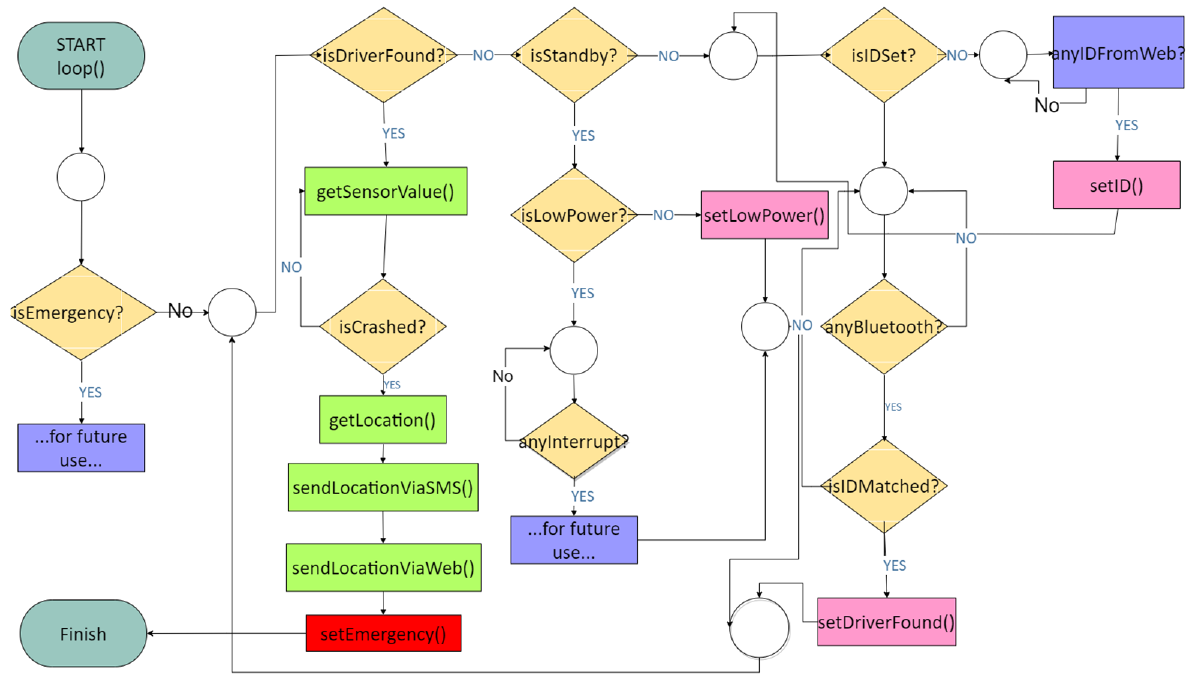
Figure 6. Flowchart of smart driver system.